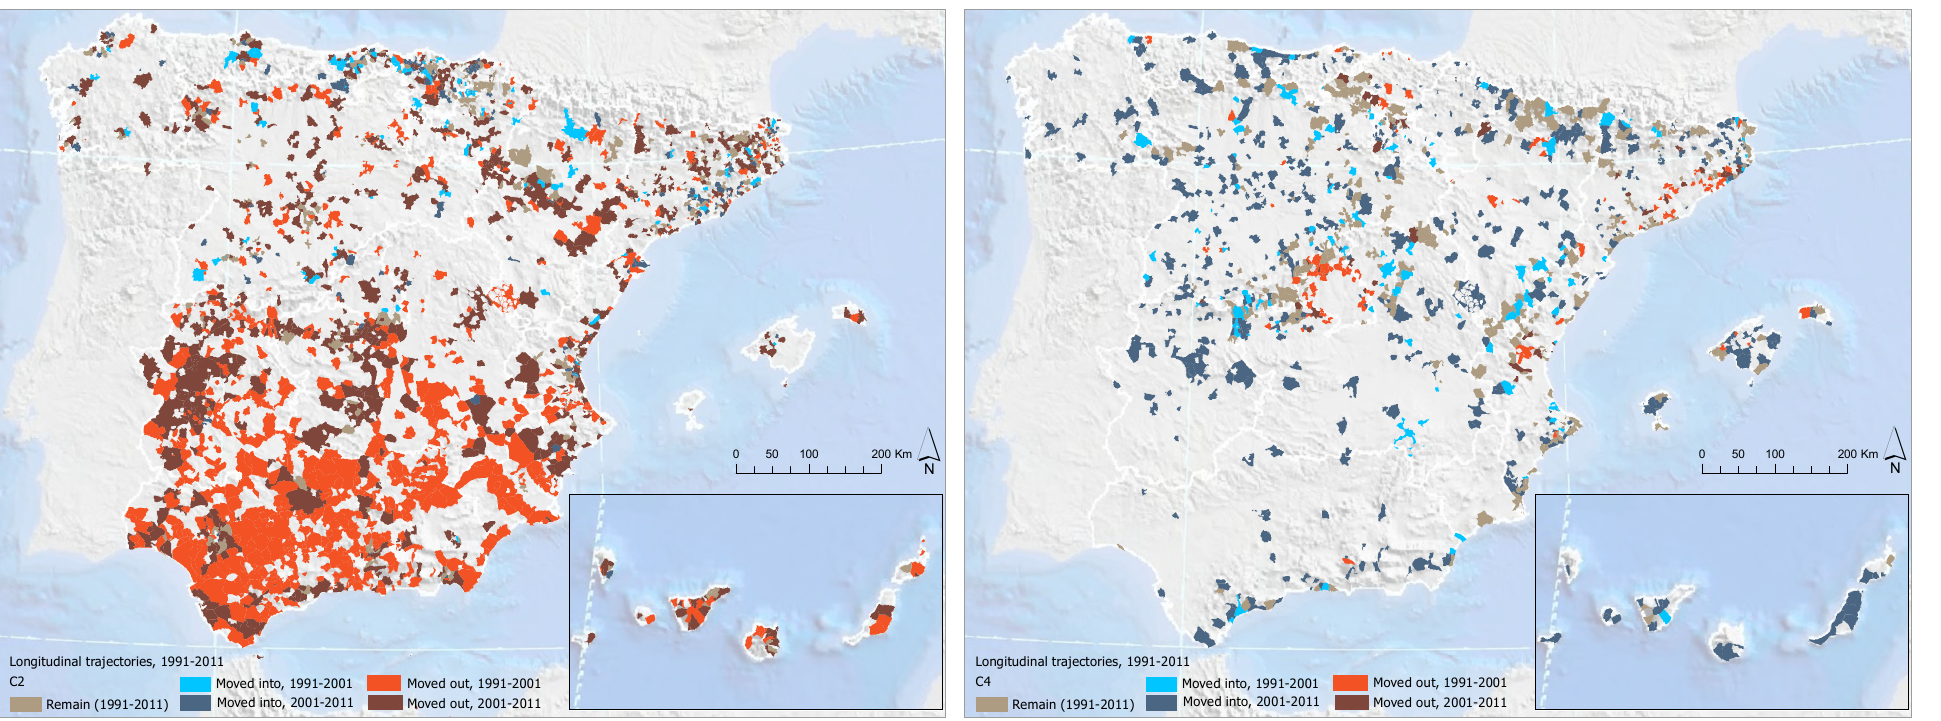
Figure A7. Visualization of longitudinal trajectories from a geographical perspective (part